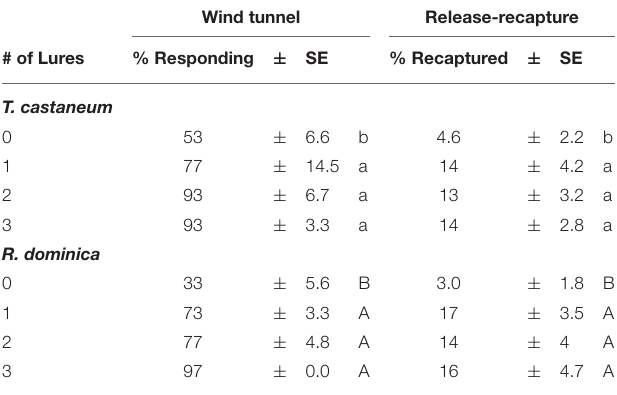
Lower case letters represent multiple comparisons among different numbers of lures for T. castaneum, while upper case letters represent multiple comparisons among different numbers of lures for R. dominica ( χ 2 -test, Bonferroni Correction).